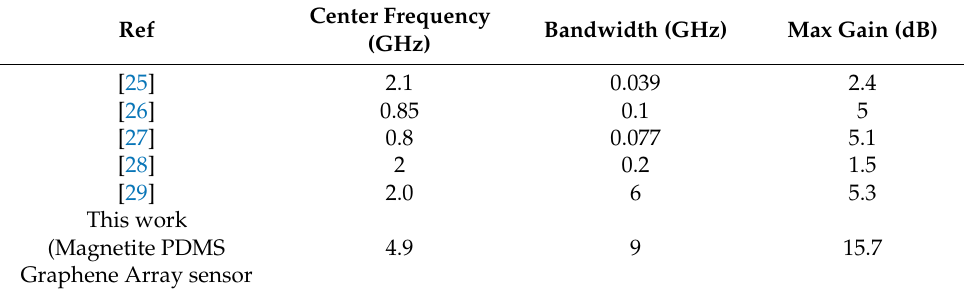
Table 1. Different Antennas with Magneto-Dielectric Substrates.